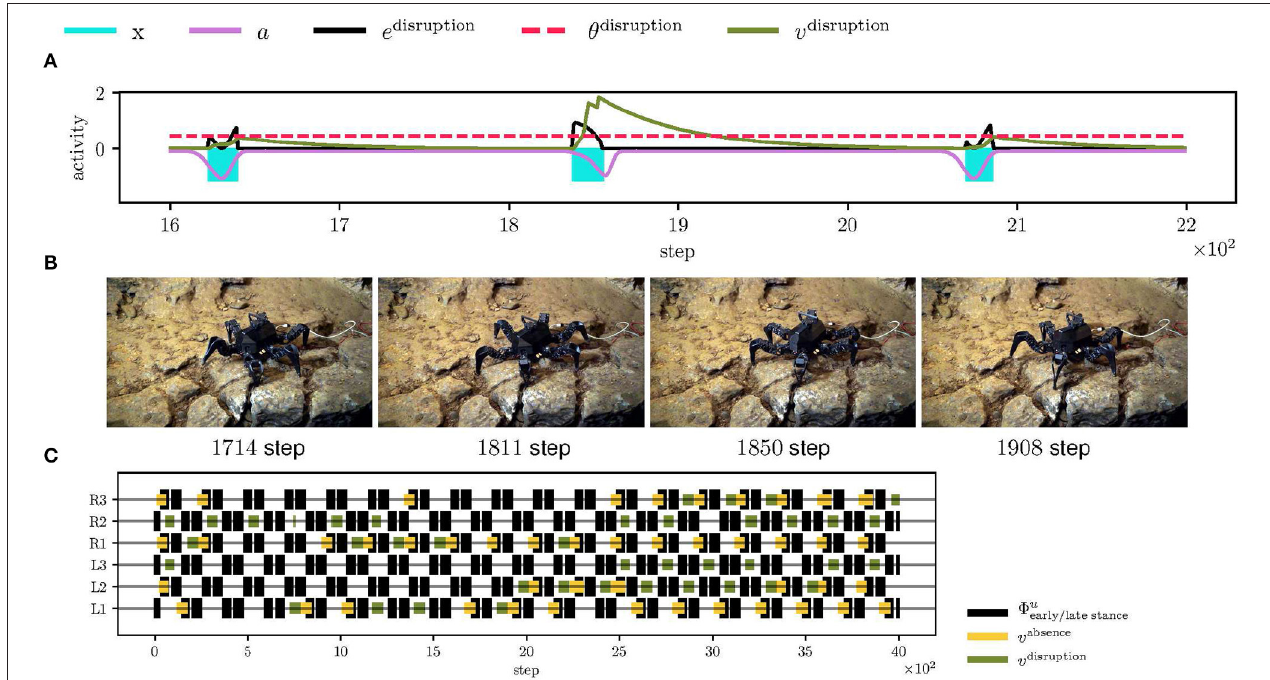
FIGURE 11 | The hexapod walking robot deployed in the Bull Rock cave. (A) During the traversal, the front left (L1) leg got stuck in a crack for two gait-cycles. At step 1,850, the leg detects the swing stop disruption and performs the elevator reflex. (B) The elevator reflex worked well in this context and successfully freed L1. (C) An overview of the triggered reflexes. In the examined unstructured environment, the motion was highly irregular, which resulted in many triggered